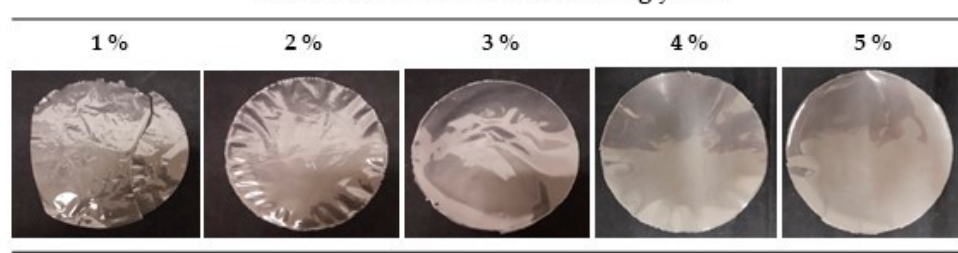
* Means and standard deviation followed by the same lowercase letter in column did not differ statistically from each other by the Tukey test at p > 0.05.